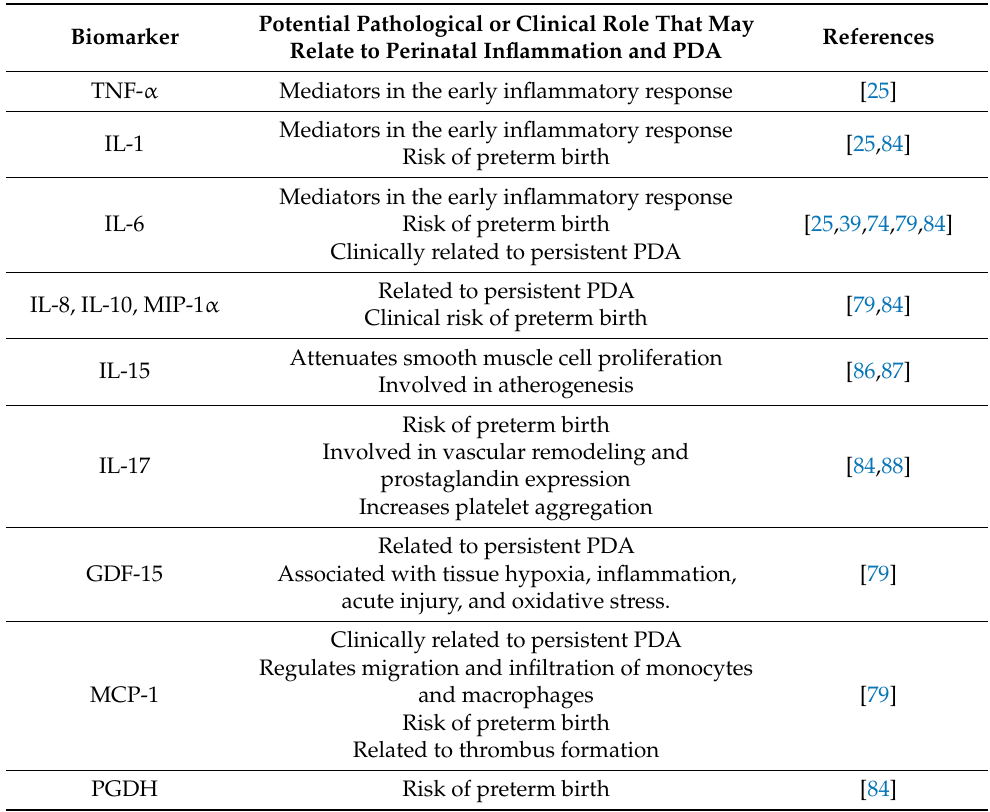
Table 2. Potential biomarkers involved in PDA